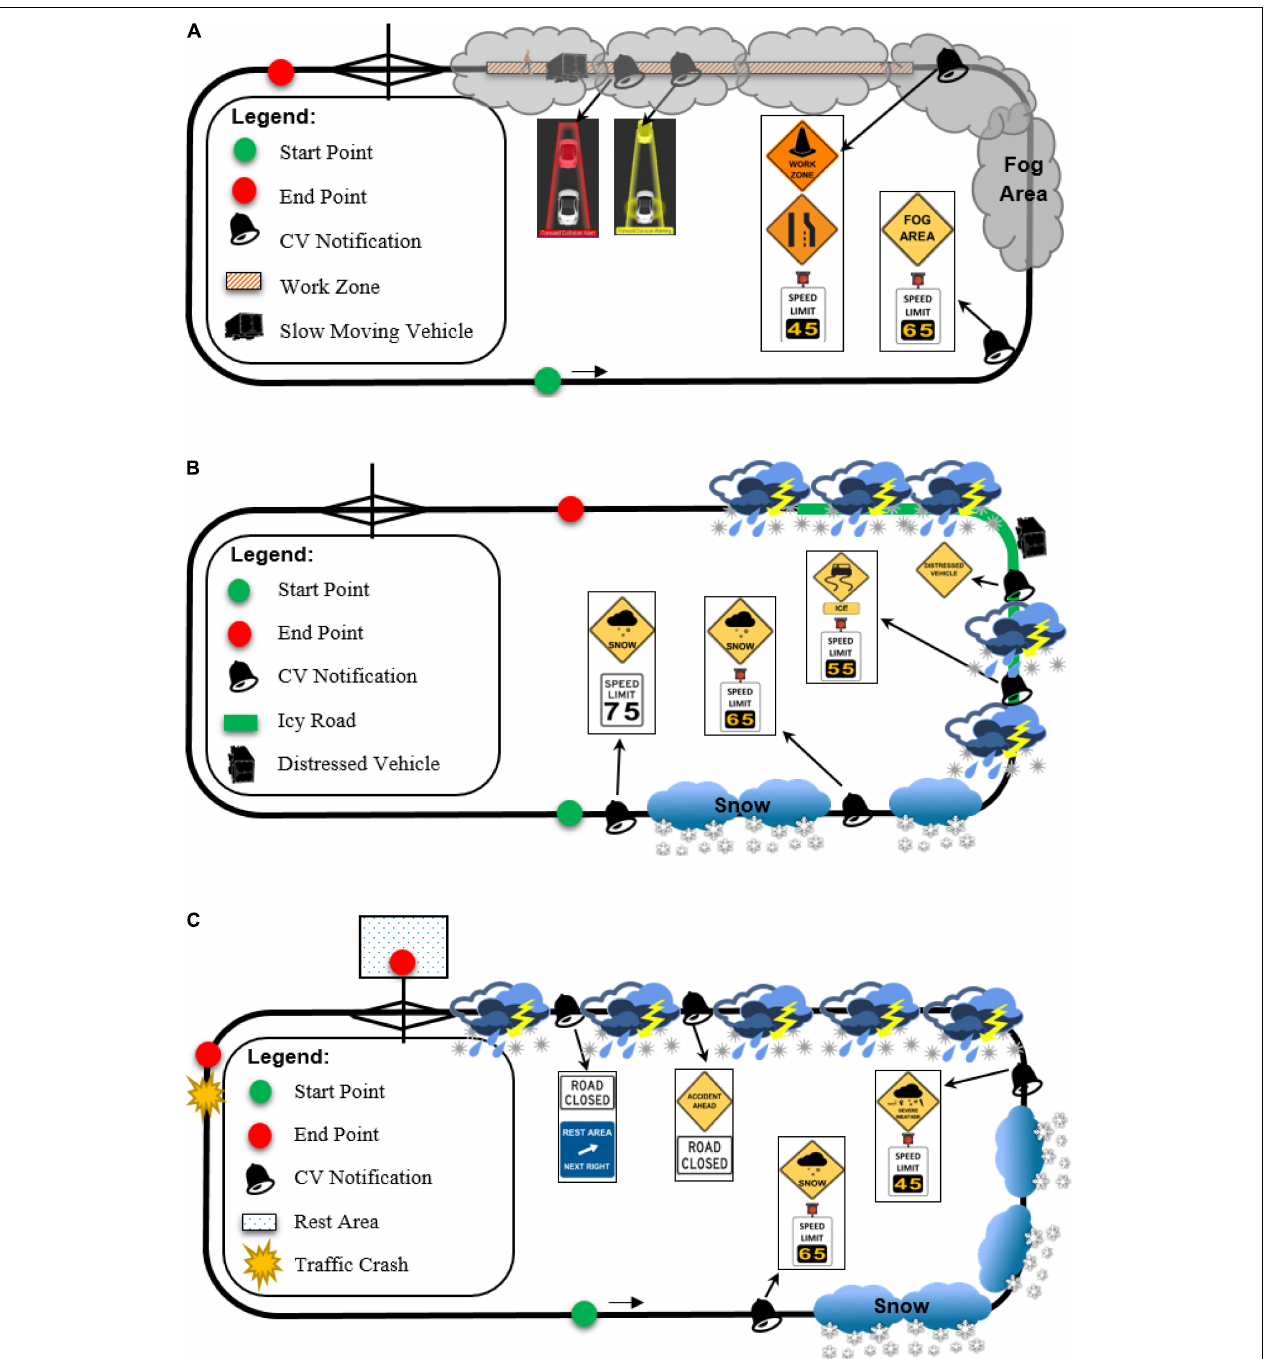
FIGURE 4 | Description of driving simulator study scenarios: (A) work zone with FCW in fog; (B) slippery road surface due to snowy weather; (C) road closure due to accident in severe weather.